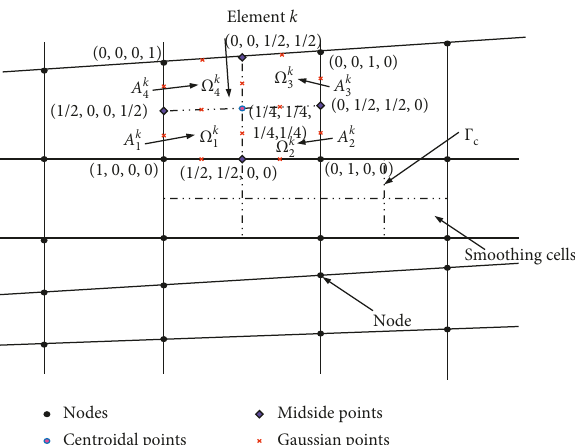
Figure 2: Smoothing subcells and the values of shape functions (reproduced from Zheng et al. [64] under the Creative Commons Attribution License/public